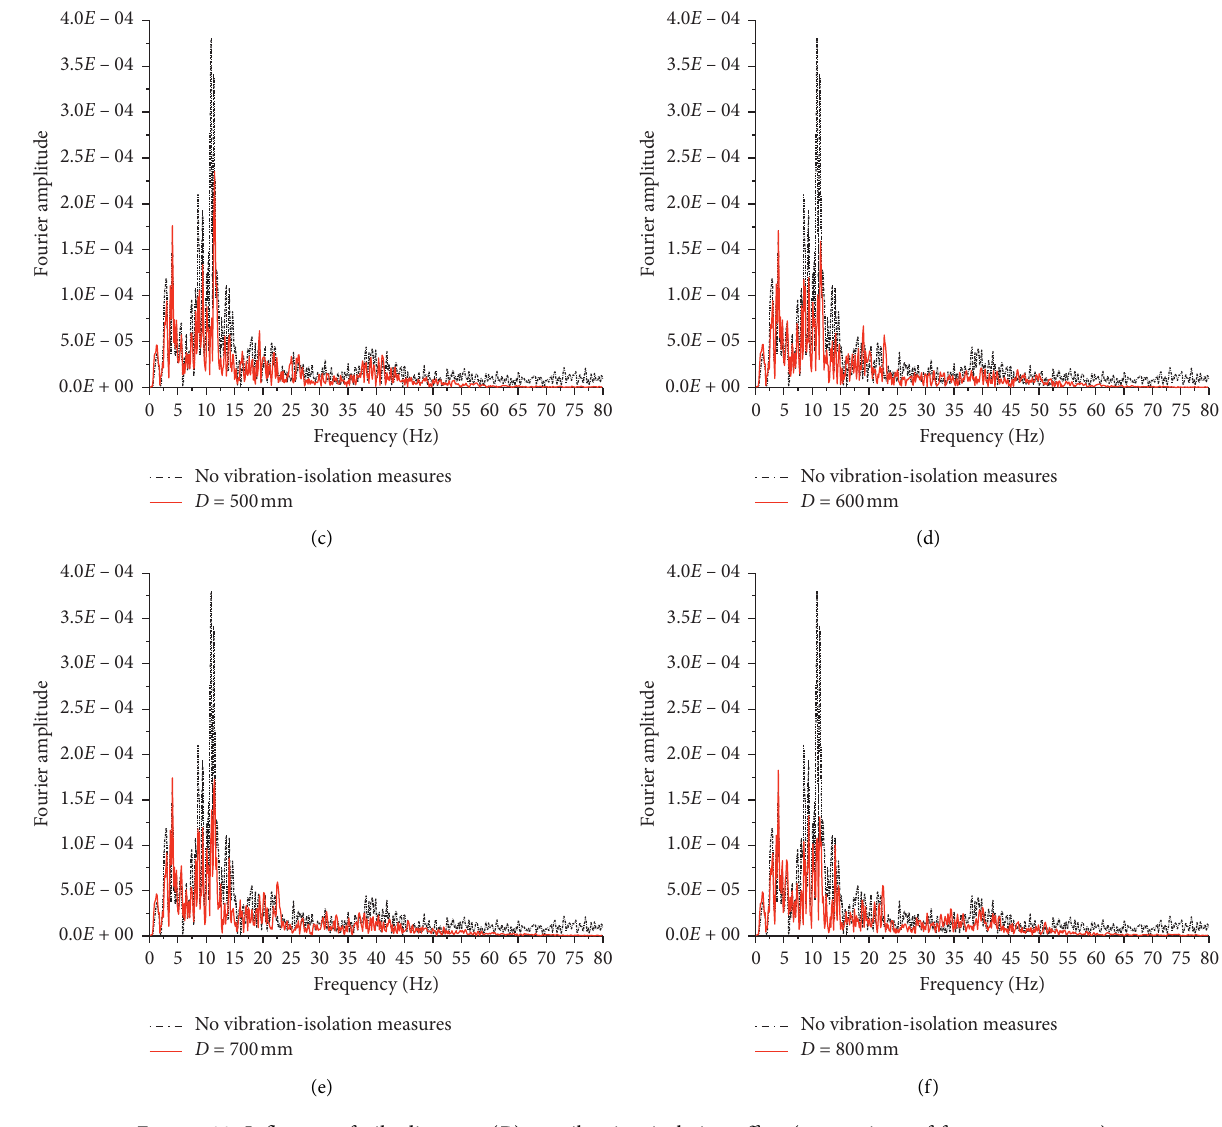
Figure 33: Influence of pile diameter ( D ) on vibration-isolation effect (comparison of frequency spectra).